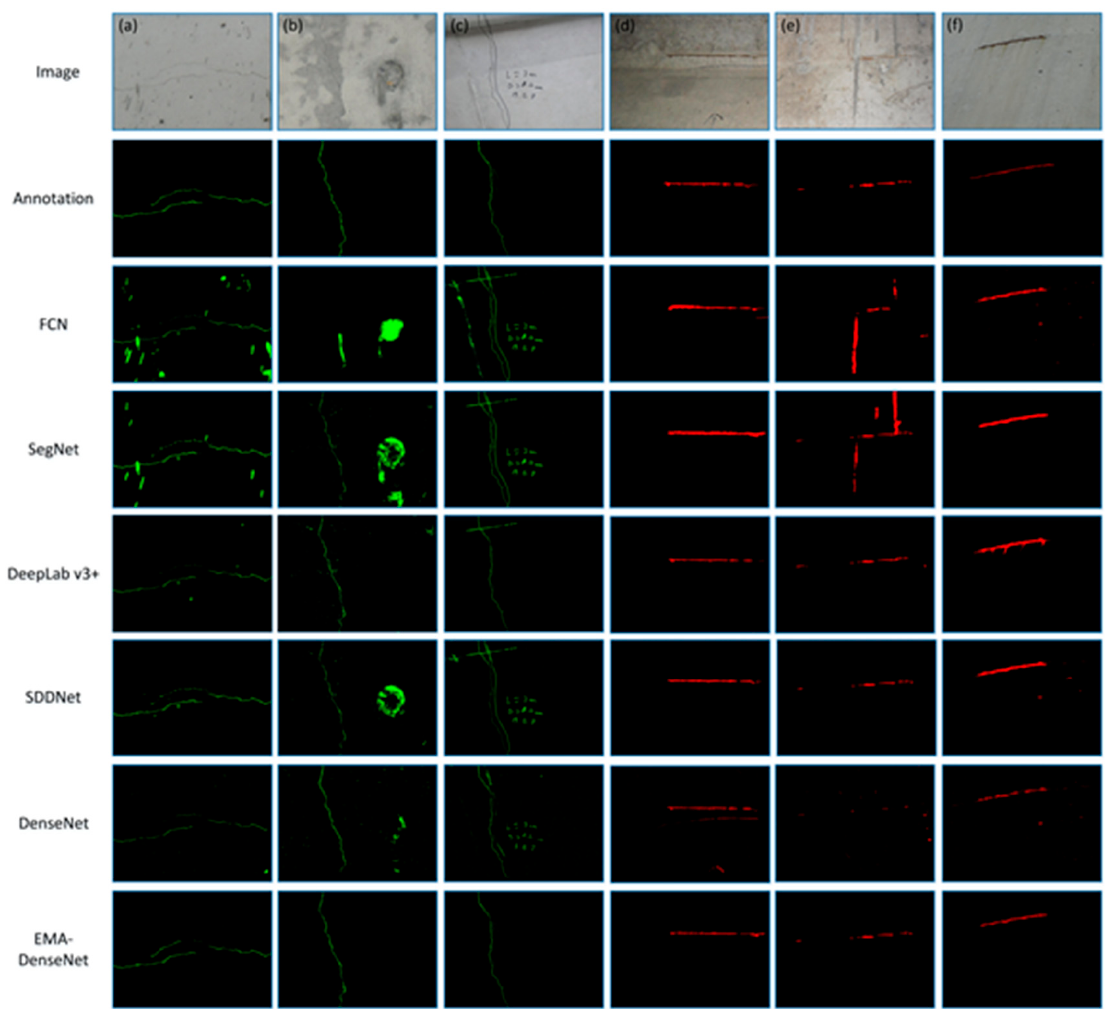
Figure 10. Prediction results for some bridge damage images, the images ( a – f ) are randomly selected from the test